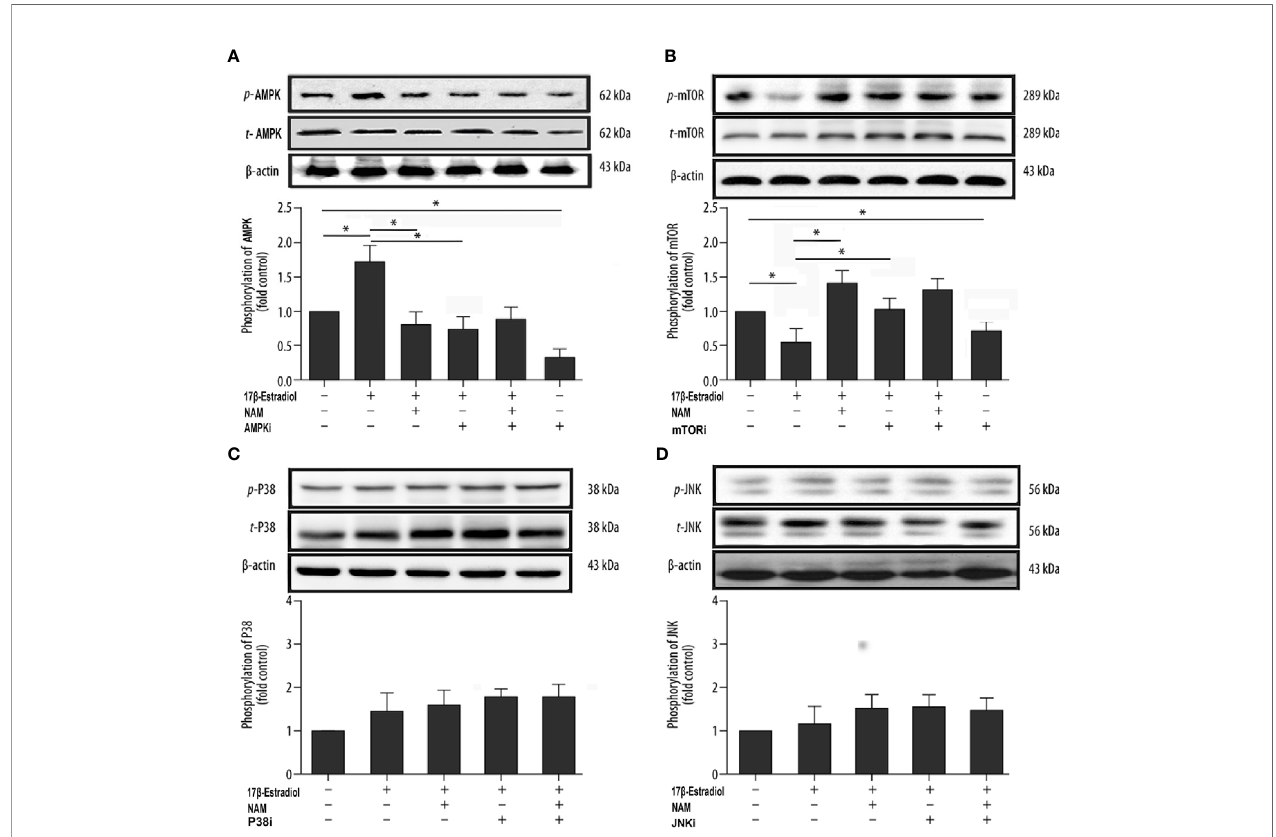
FIGURE 5 | 17 b -E2 induced mitophagy through the SIRT1-mediated AMPK/mTOR pathway in ATDC5 chondrocytes. The ATDC5 chondrocytes were treated with 17 b -E2 (0 M or 1 × 10 -7 M), with or without pretreatment with NAM, AMPK inhibitor, mTOR inhibitor, p38 inhibitor, and JNK inhibitor. Then, the expression of p- AMPK (A) , p-mTOR (B) , p-p38 (C) , and p-JNK (D) in ATDC5 chondrocytes was measured by Western blot analysis. b -actin was used as an internal control to normalize the data. Data are presented as the mean ± SD of three independent experiments. * P < 0.05 versus the control group indicated a signi fi cant